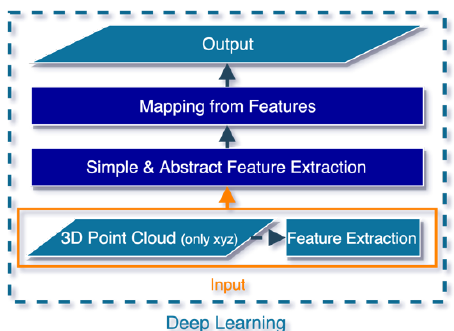
Figure 3. Our proposed framework. (Dark blue boxes show modules that can learn from data.)